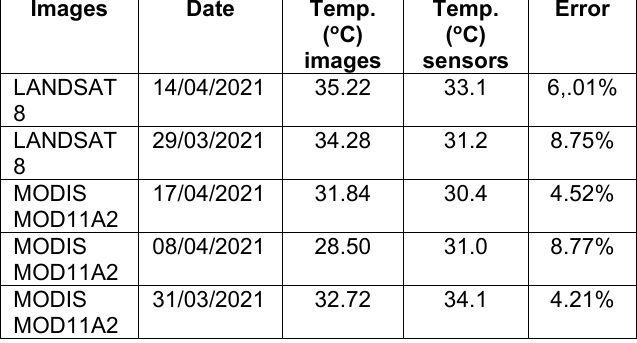
Table 4. Values of land surface temperature from images and from sensors Images